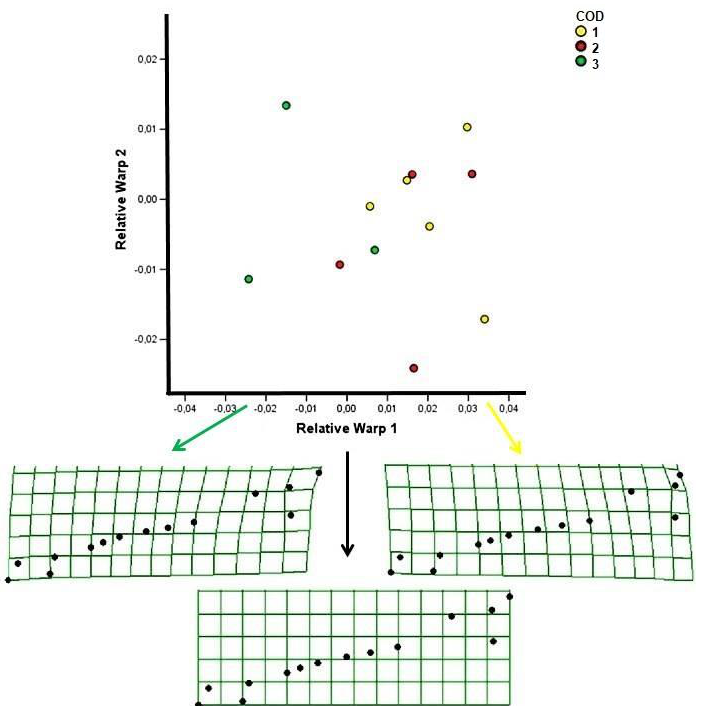
Figure 4. RWs (axis 1 and 2) of mandibles pertaining to subjects aged 0–8 months. Deformation grids evidence the sample shape modification along RW1 with respect to the consensus grid linked to the environmental category of the samples. COD 1, 2, 3 indicates the environmental cate- gory.